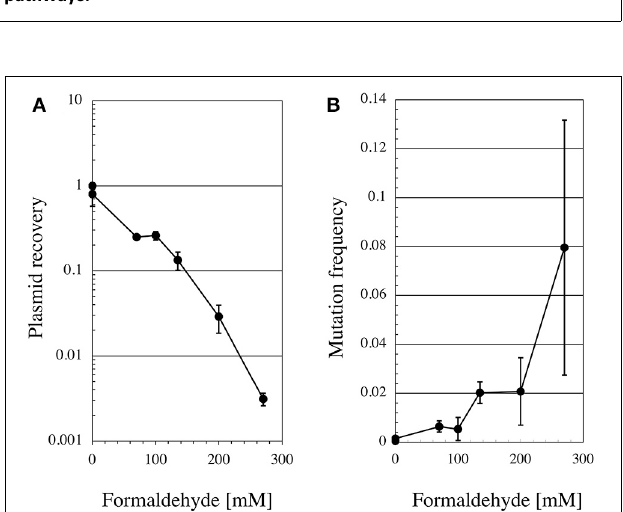
FIGURE 2 | Types of DNA damage induced by formaldehyde and their repair pathways.